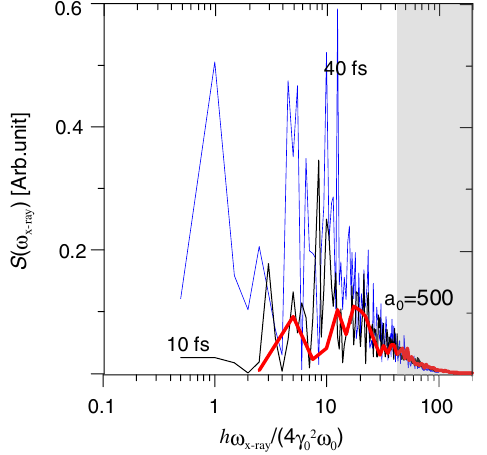
FIG. 4. Spectra of backward scattering ( θ ¼ π ) with a 0 ¼ 100 Gaussian pulses of duration 10 fs (black curve) and 40 fs (blue curve) for a head-on collision, γ ¼ 2000 , with radiation damping, and (red curve) 10 fs laser pulse with a 0 ¼ 500 .